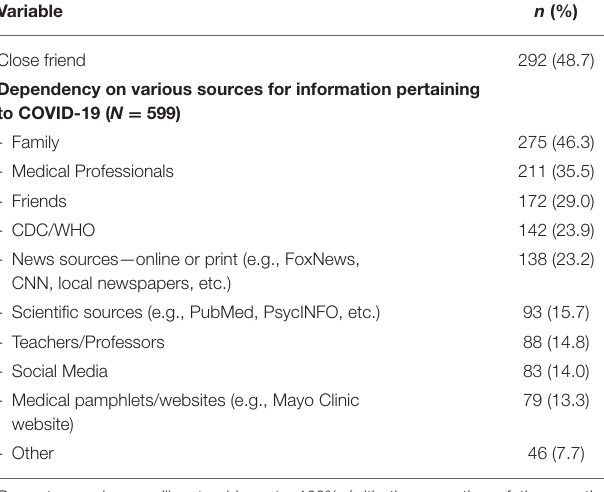
TABLE 2 | Summary of pandemic-related demographic